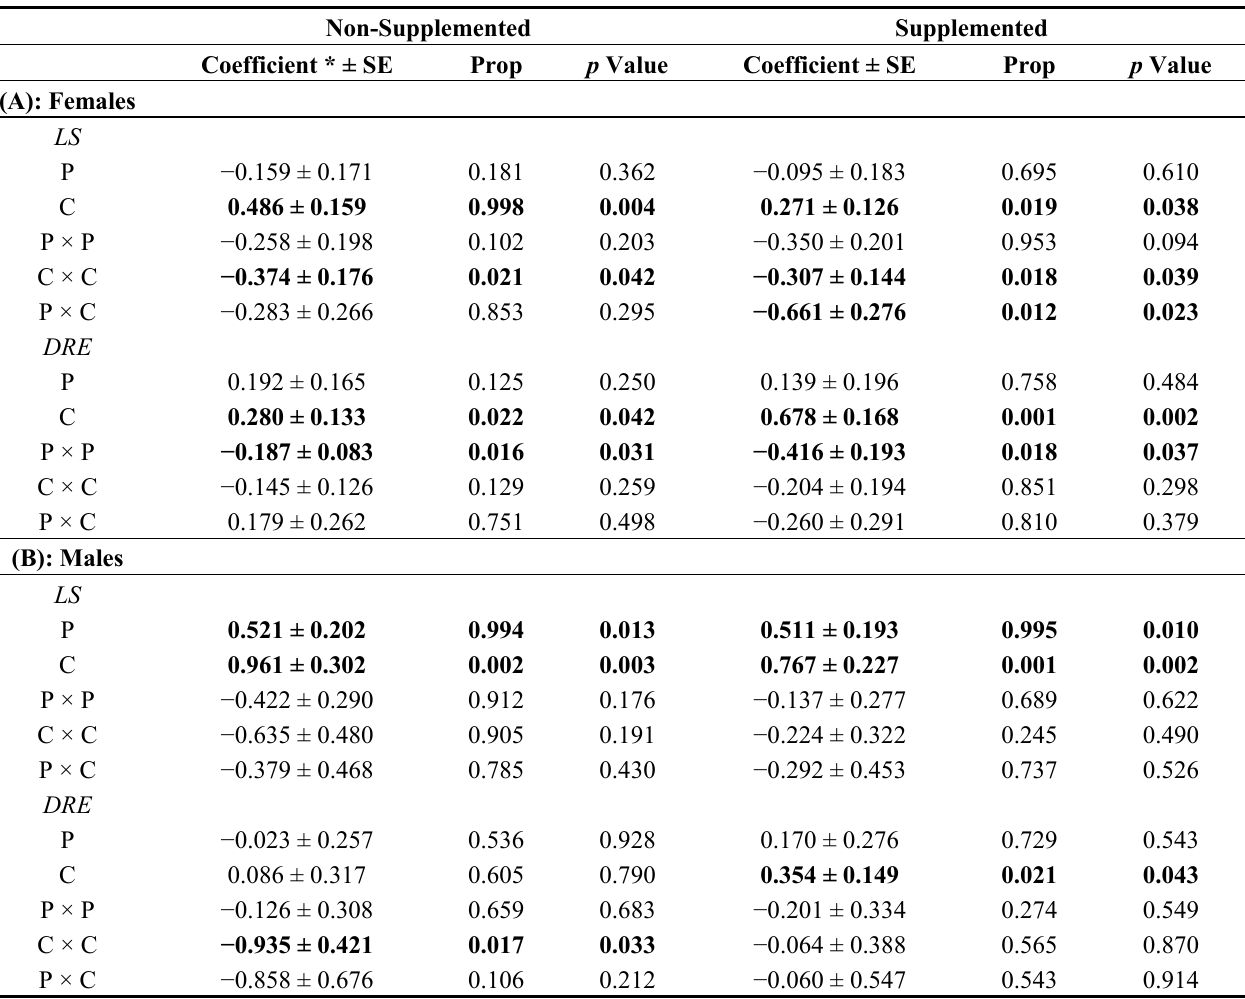
Table 1. The linear and nonlinear effects of daily protein (P) and carbohydrate (C) intake on the lifespan (LS) and daily reproductive effort (DRE) of ( A ) female and ( B ) male T. commodus with and without DL -alpha-tocopherol supplementation. Significant effects are highlighted in